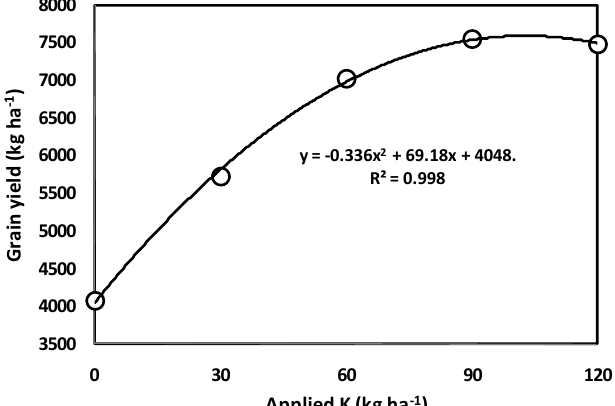
Figure 1. Dose–response curve showing the regression between applied K (kg ha − 1 ) and grain yield (kg ha − 1 ) (Optimum dose of potassium/K opt = 101.5 kg ha − 1 ). Table 3. Growth attributes of hybrid rice (var. Arize 6444) as influenced by potassium fertilization (means for 2016 and